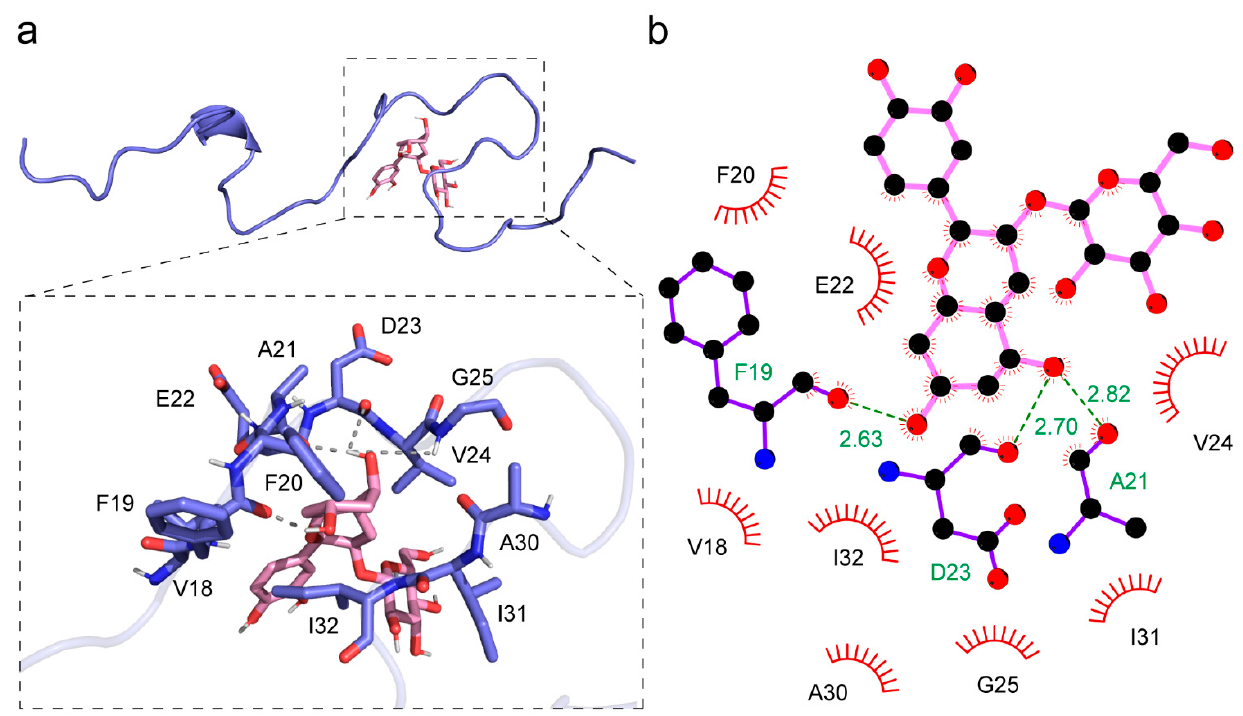
Figure 3. Detailed interaction between Cy-3G and an A β peptide. ( a ) The binding site between Cy- 3G and an A β peptide. The slate carton representation is the A β peptide solution structure, and the pink stick presents Cy-3G. ( b ) The interaction details between Cy-3G and the A β peptide. The dashed lines represent hydrogen bonding, and amino acid residues involved in hydrophobic interactions were shown.